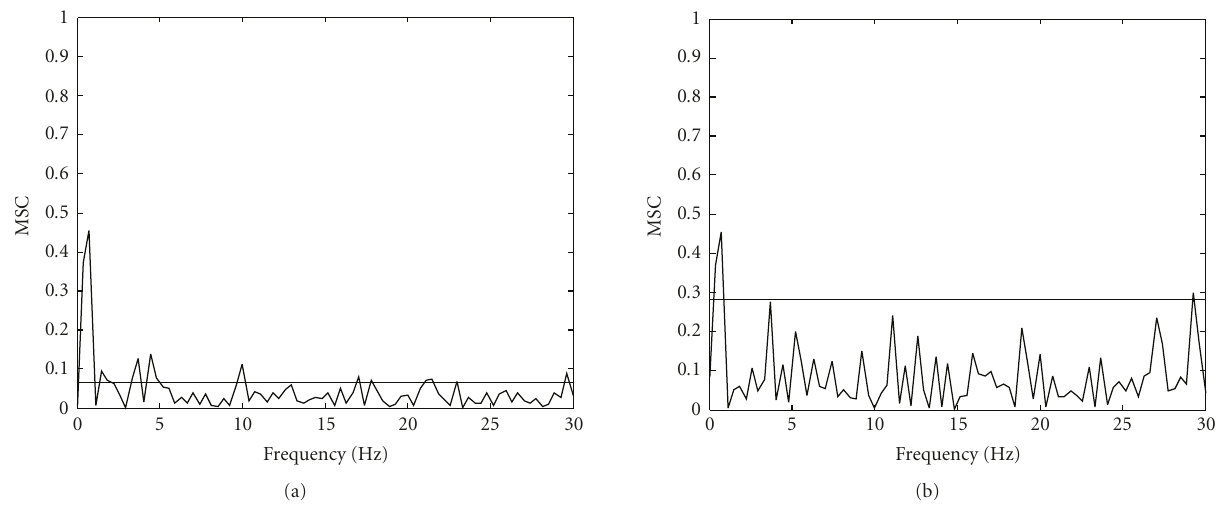
Figure 12: ERP statistical detection (Cz channel) related to movement imagination, for subject #1, using the MSC (a) M = 45; (b) M = 10.